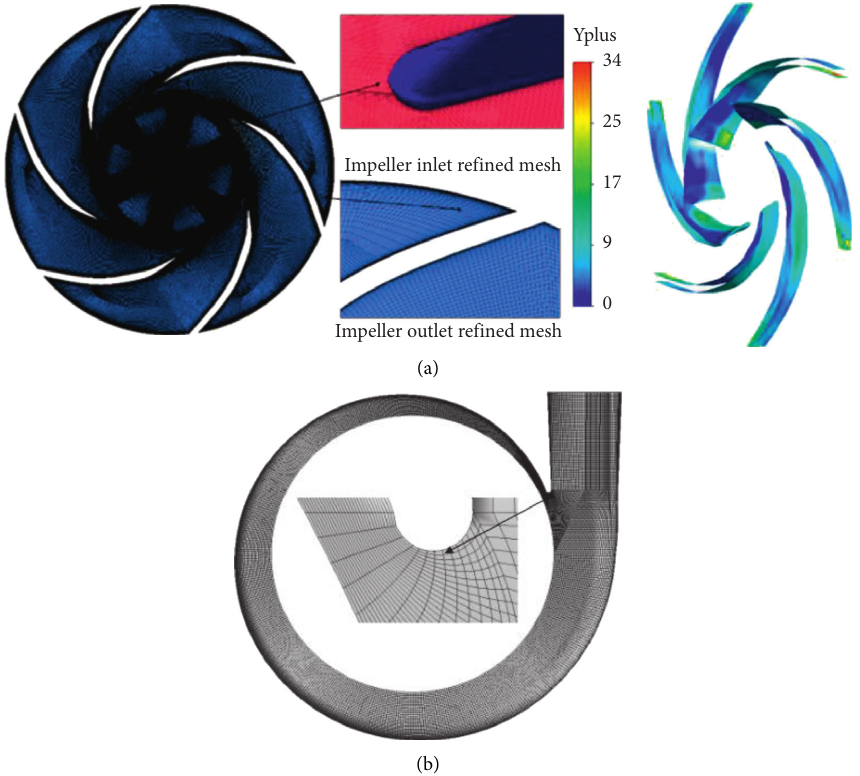
Figure 4: Turbine mesh generation. (a) Impeller grid and Y + values of blades. (b) Spiral case